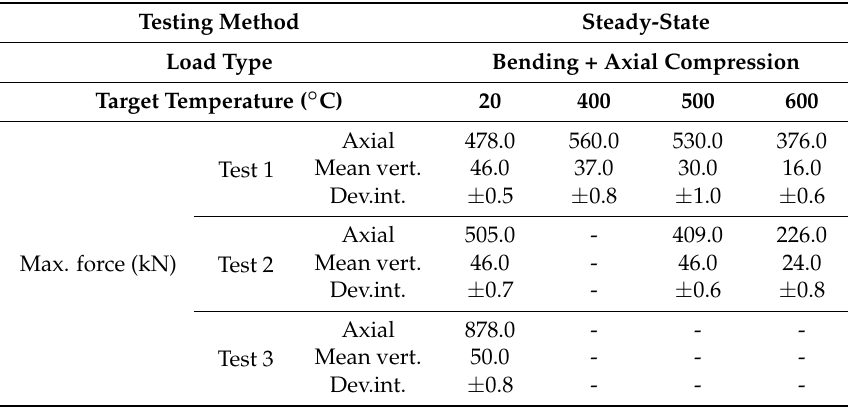
Figure 3. Temperature measurements at various points on the column specimen at: ( a ) 400 °C; ( b ) 500 °C; and ( c ) 600 °C. Table 1. Summary of test results for column capacity tests.